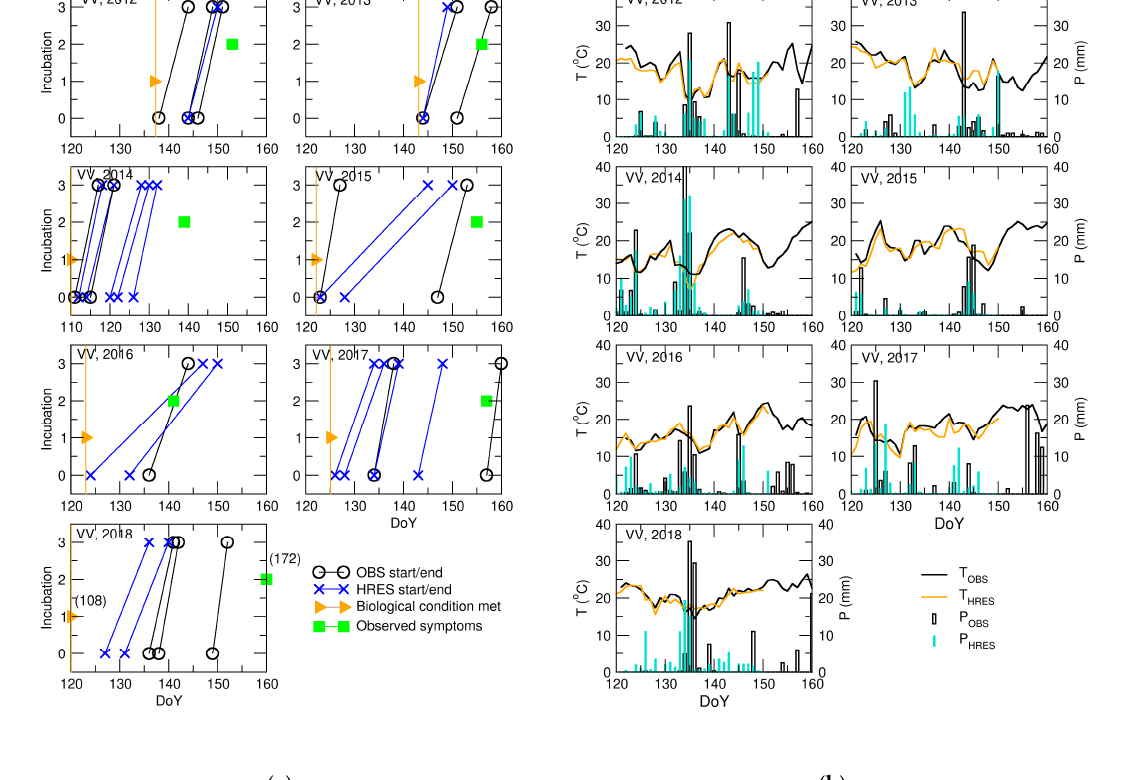
Figure 7. BAHUS-P runs with ( a ) observed (OBS; o) and forecasted meteorology (HRES; x) on days when phenological conditions for disease development were met for primary infection (10 cm shoots; orange triangles) and disease was observed (green squares); ( b ) observed and predicted temperature (T OBS , T HRES ) and precipitation (P OBS , P HRES ) in the same period at VV location.